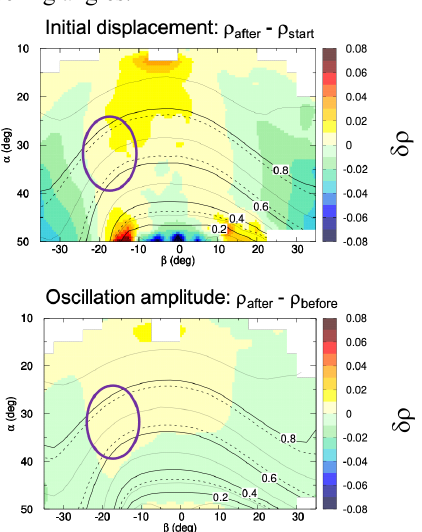
Fig. 7 . Displacement dr of the ECCD location due to n e modifications due by pellets varying toroidal and poloidal angles for pellets of 0.7 mm (top: between the case just after pellet and without pellet, bottom: between the case just after pellet and just before pellet). Black contours: reference ECCD location (before pellet injection). Dashed lines represent the rational q surfaces (R=2.14 m configuration). Violet ellipse highlights the optimized intervals of injection angles which reach the rational q surfaces 2 and 3/2.